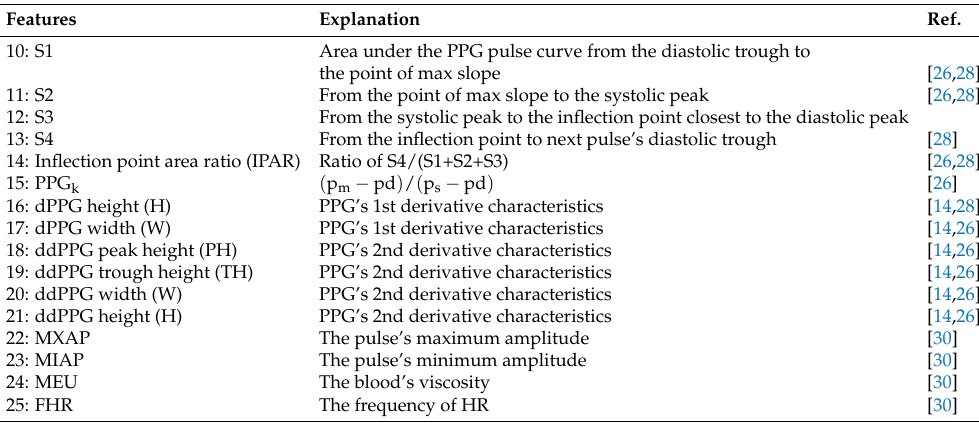
Table 3. Summary of the features, part II, where p m denotes the area under the pulse divided by the pulse duration, p d is the minimum intensity of the PPG signal, and p s denotes the maximum intensity of the PPG